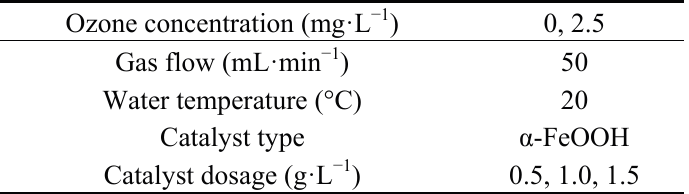
Table 1. Operating conditions for the catalytic ozonation